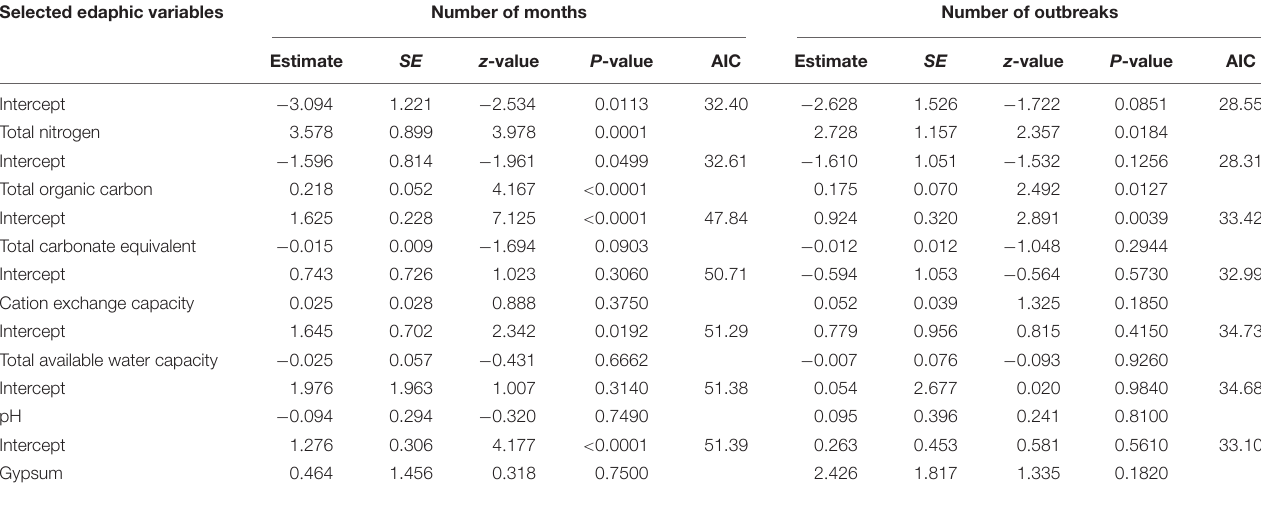
TABLE 5 | The influence of selected edaphic variables on the number of months and the number of anthrax outbreaks in focal wildlife areas of Kenya 2000–2019. Selected edaphic